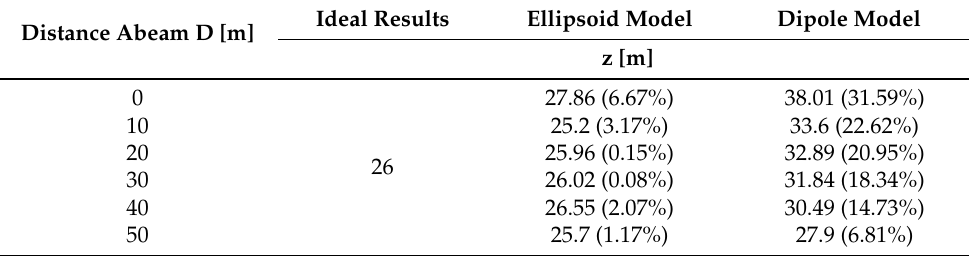
Figure 6. Comparison of the spheroid model with the magnetic dipole model to the recorded GPS value when the distance abeam is 30 m. “GPS” represents the recorded GPS value. “Dipole model” represents the calculated results of the dipole model. “Ellipsoid” represents the calculated results of the ellipsoid model. Table 3. The comparison of Localization results in the z -direction between magnetic dipole model and ellipsoid model for different distance abeams (the sea depth is 26